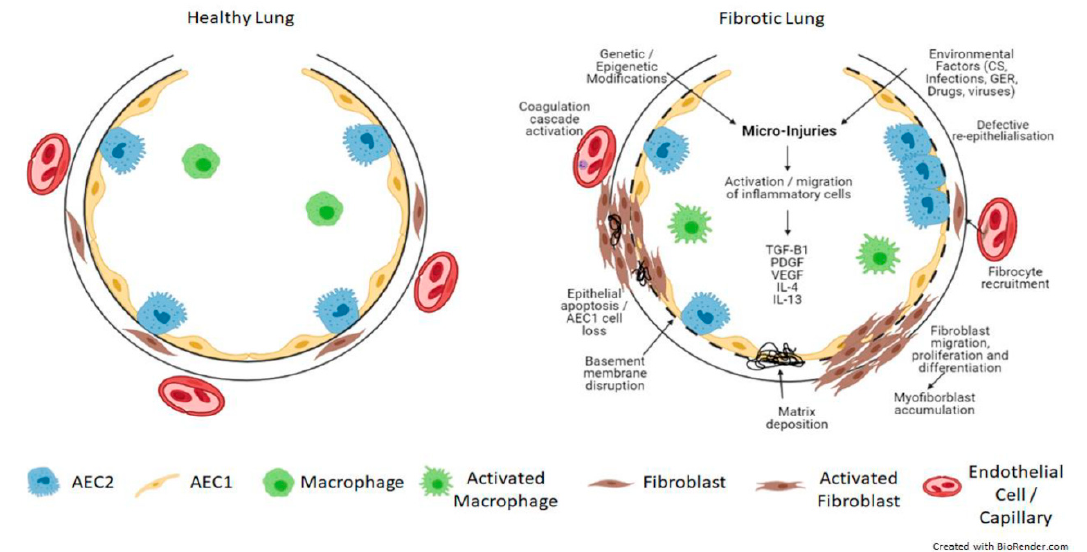
Figure 1. Schematic view of the pathogenesis of pulmonary fibrosis. Genetic and epigenetic factors in combination with repeated injury from environmental factors to the lung alveolar epithelium result in epithelial and endothelial cell damage and the disruption of the basement membrane. This initiates an inflammatory response and the secretion of pro-fibrotic cytokines such as TGF- β , PDGF, VEGF, IL-4 and IL-13. This results in the activation of the coagulation cascade, abnormal vascular remodelling and repair and aberrant epithelial-mesenchymal crosstalk, together with the recruitment, migration and differentiation of fibroblasts/fibrocytes into myofibroblasts. These myofibroblasts are resistant to apoptosis and accumulate, resulting in extracellular matrix deposition and the formation of fibrotic lesions, which leads to progressive lung remodelling and architectural distortion. TGF- β = transforming growth factor beta; PDGF = platelet ‐ derived growth factor; VEGF = vas ‐ cular endothelial growth factor; IL ‐ 4 = interleukin 4; IL ‐ 13 = interleukin 13. Created with BioRender.com.